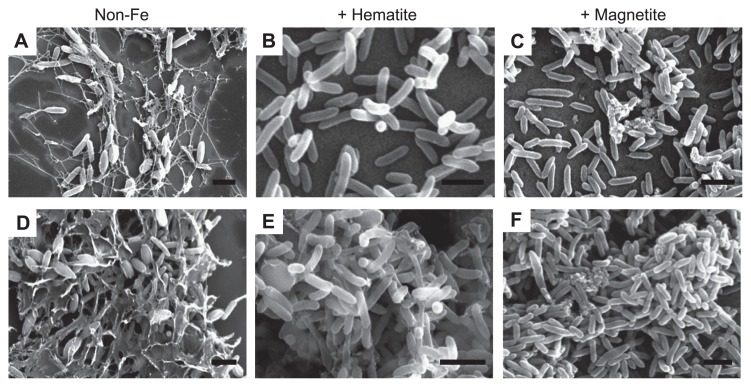
SEM images of G. sulfurreducens cells growing on ITO electrodes. Cells were sampled during current generation from non-Fe (A, D), +Hematite (B, E), and +Magnetite (C, F) cultures. Images show cells when current was increased (A–C) and those after current densities reached the maximum values (D–F). Bars are 2 μm.